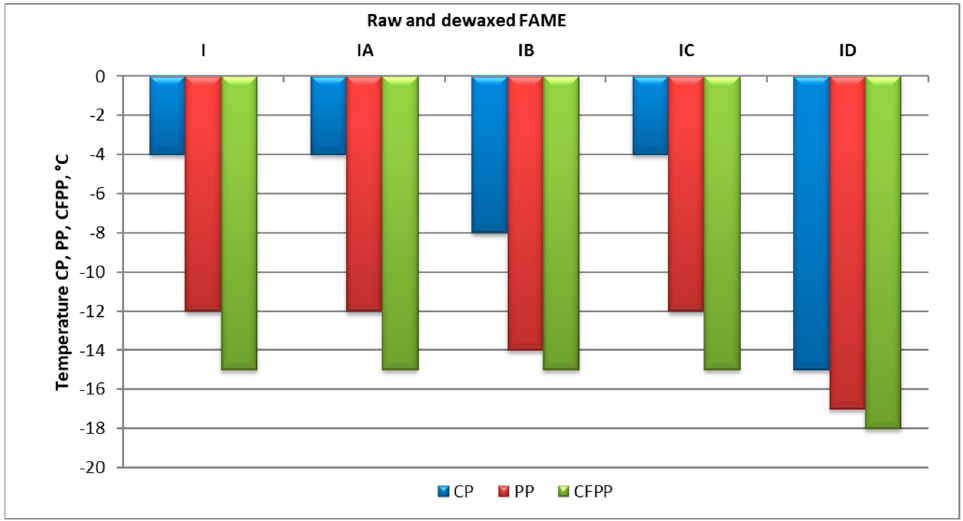
Figure 2. Low-temperature properties of raw FAME I and modified biofuels.